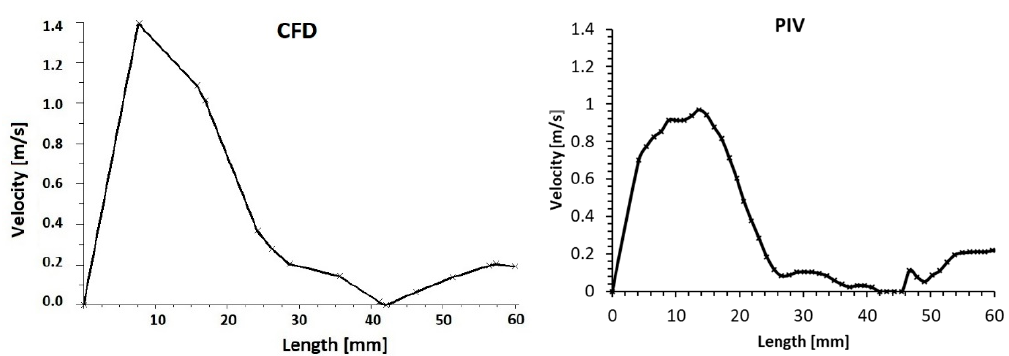
Figure 13. Velocity graphs in cross-section behind the first baffle for setting 3.